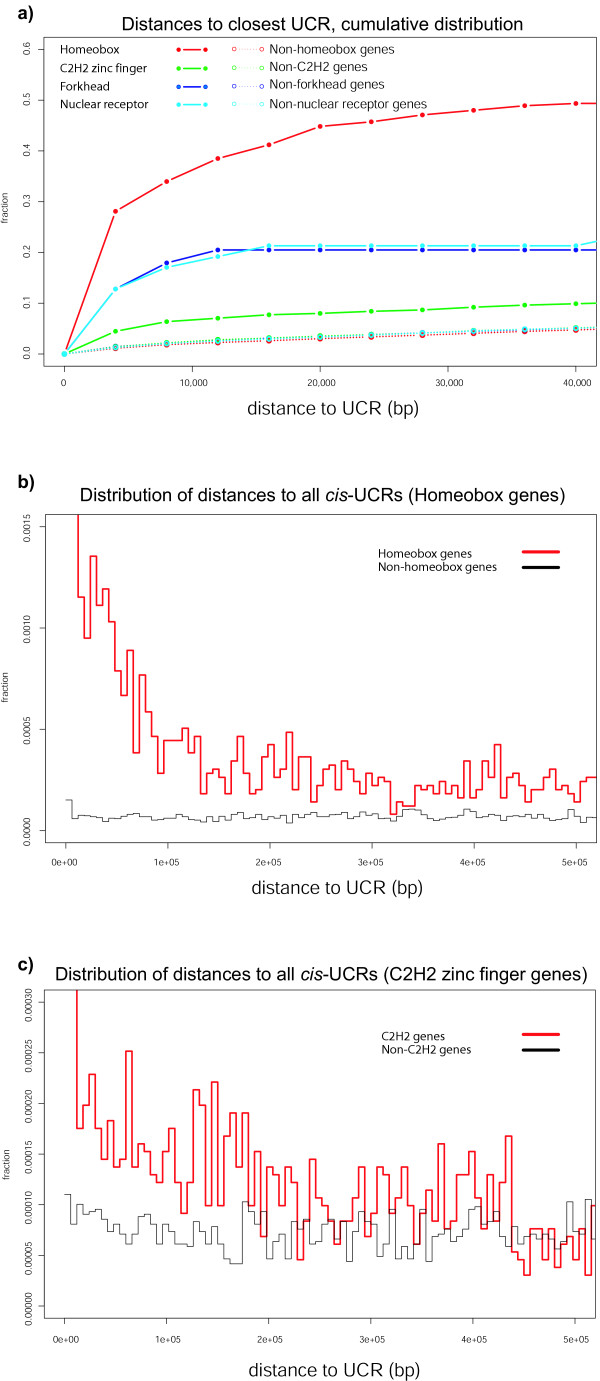
Spatial correlation of transcription factor gene families to UCRs in the human genome. A. Cumulative distribution of distances to the closest UCR for selected subsets of genes. Distance to the closer end of the transcript mapping (either 3' or 5'). Majority of major classes of transcription factors are closer to UCRs than random genes. B, C. Occurrence of UCRs around selected subsets of genes. This plot summarizes the distribution of distances to all UCRs on the same chromosome for each gene in the subset. There is a visible over-representation of UCRs up to 300 kb from homeobox genes, and up to 150 kb from C2H2 zinc finger genes.